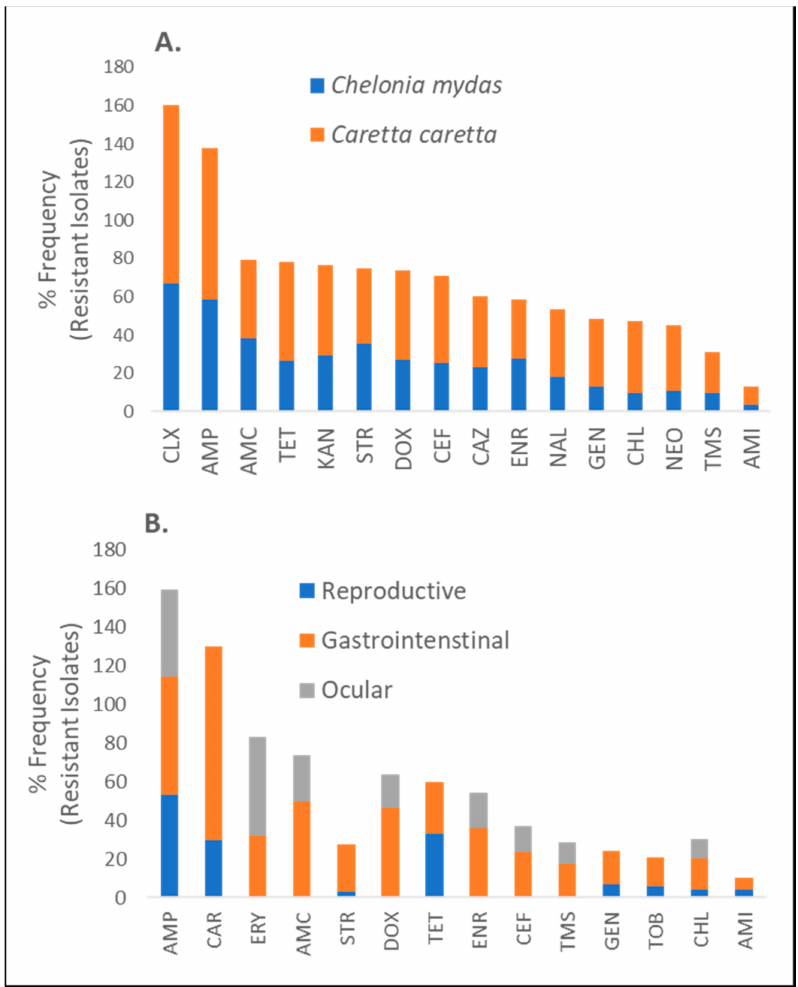
Figure 3. Frequency distribution of AR against commonly used antibiotic drugs stratified by turtle species ( Chelonia mydas and Caretta caretta ) irrespective of geographical marine environment, biologi- cal specimen considered, or tested bacterial isolates ( A ) and frequency distribution of AR stratified by considered biological specimen irrespective of geographical marine environment, turtle species, or tested bacterial isolates ( B ). Abbreviations are defined as: AMI = Amikacin; AMO = amoxicillin; AMC = Amoxicillin-clavulanic acid; AMP = Ampicillin; CAR = Carbenicillin; CAZ = Ceftazidime; CEF = Ceftiofur; CLX = Cephalexin; CHL = Chloramphenicol; DOX = Doxycycline; ENR = En- rofloxacin; ERY = Erythromycin; GEN = Gentamicin; KAN = Kanamycin; NAL = Nalidixic acid; NEO = Neomycin; STR = Streptomycin; TET = Tetracycline; TOB = Tobramycin; TMS = Trimethoprim-